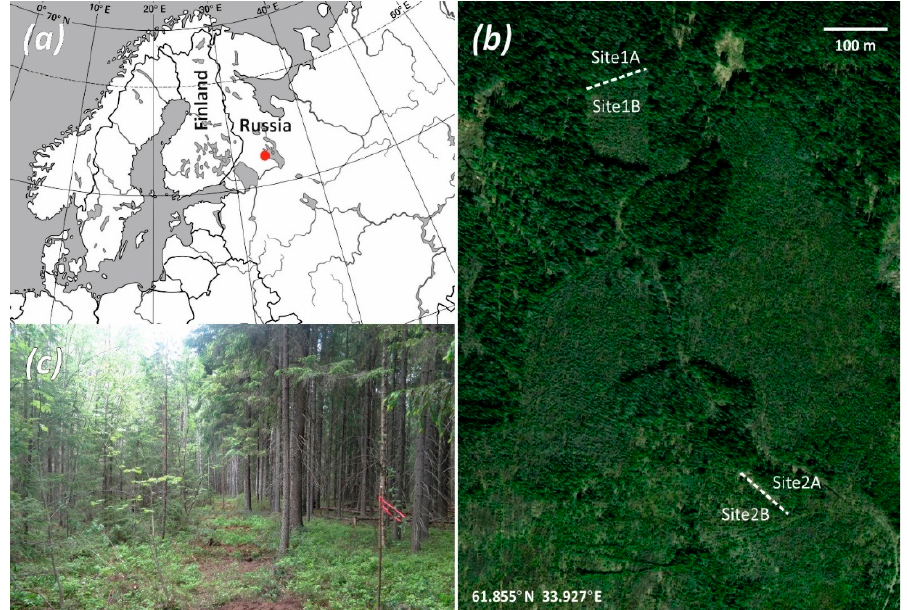
Figure 2. Location of sampling plots: ( a ) geographic location of the study area; ( b ) locations of sampling sites and plots; ( c ) photo from sampling site 2 (deciduous stand on the left, mature bilberry- type spruce forest on the right).